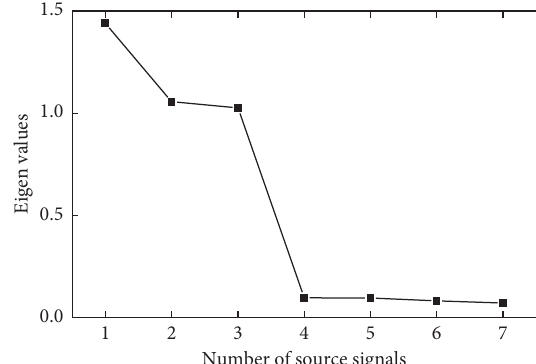
Figure 8: Correlation matrix eigenvalues.